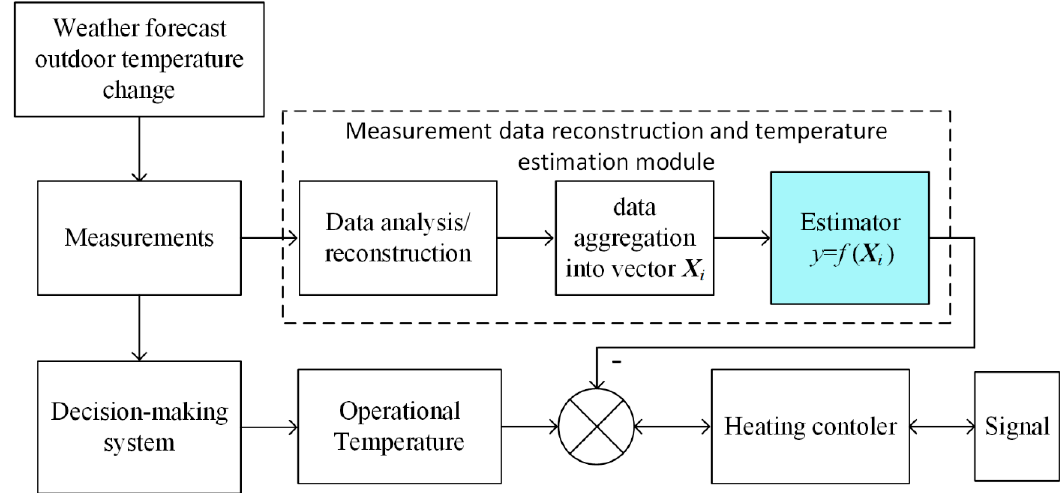
Figure 1. An overview of the control system.